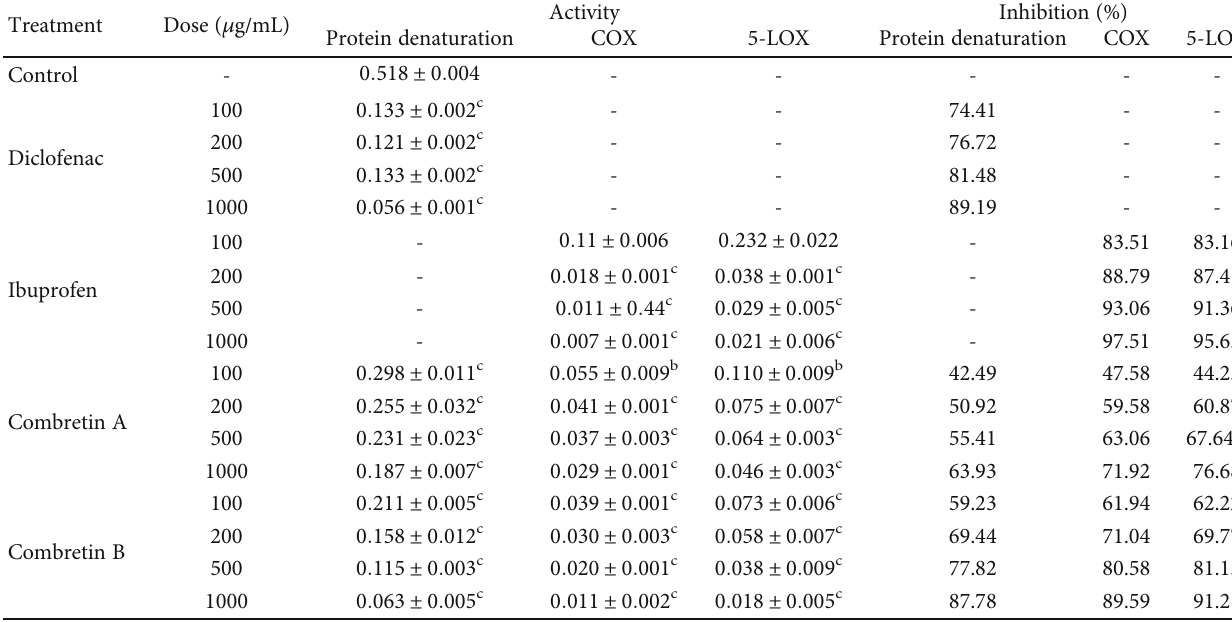
Table 1: E ff ect of Combretin A and Combretin B on protein denaturation, cyclooxygenase (COX), and 5-lipoxygenase (LOX) inhibition.